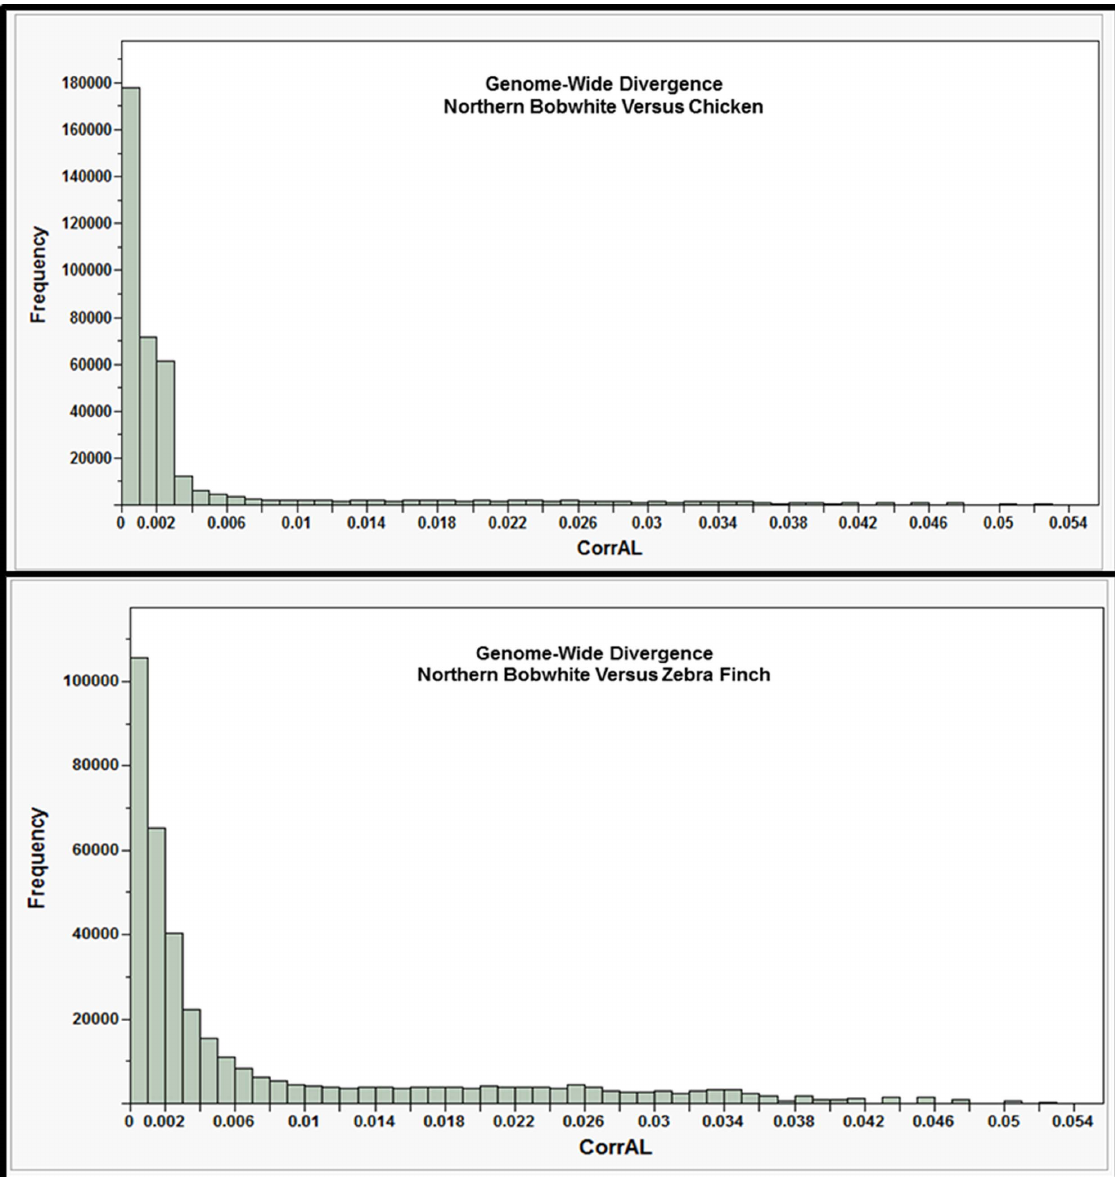
PercentID ) ( 100 [42]. The AlignmentLength conservation (Table 5; Table S11). Within these contigs, the presence of orthologous gene sequences previously associated with human cardiovascular traits (or their proximal noncoding flanking regions) was relatively unsurprising, as this result also occurred during our analysis of divergence with the chicken genome (Table 4; Table 5; Table S11), and in a previous study of the scarlet macaw genome [42]. Therefore, it is apparent that some